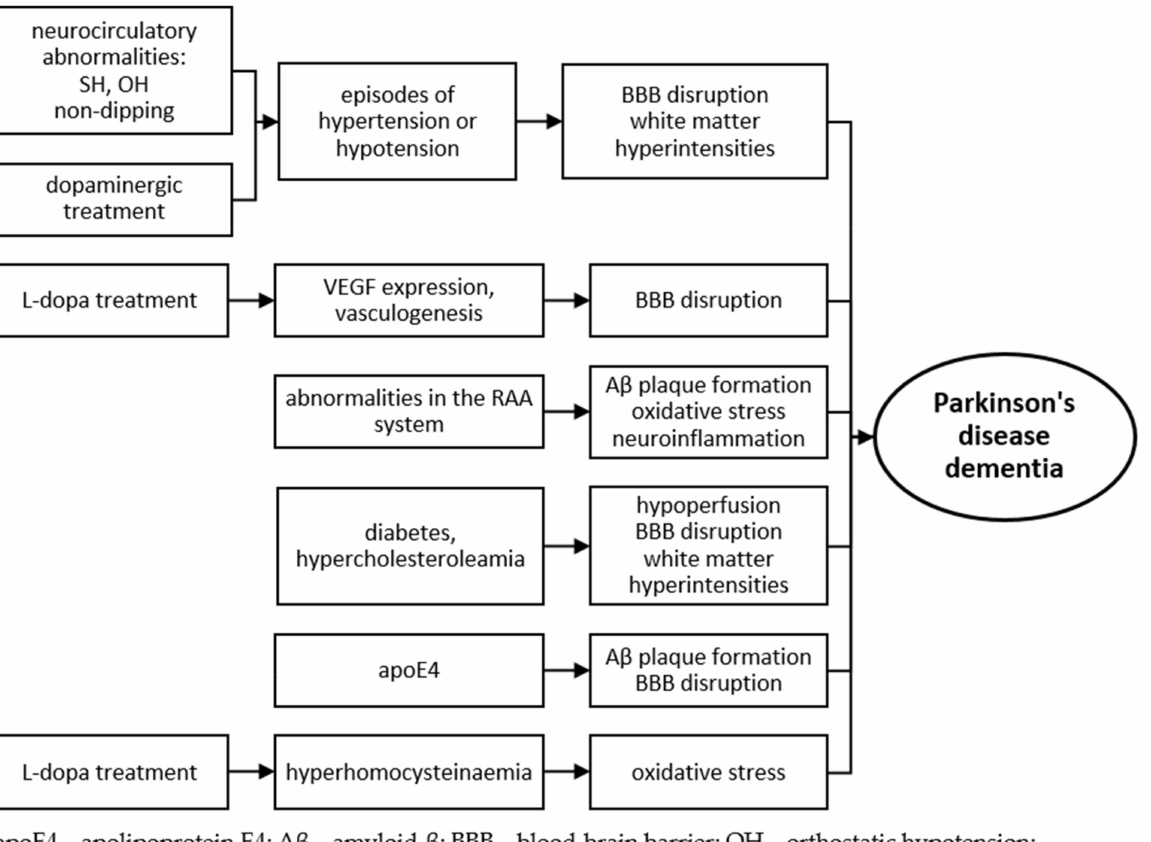
Figure 1. Possible vascular-related mechanisms leading to dementia in Parkinson’s